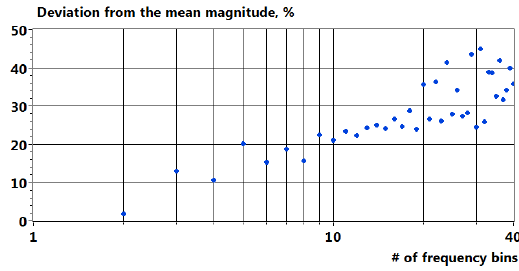
Fig.8: Relative deviation of RMS magnitudes of frequency components from their mean values of the signum chirp with normalized frequencies in the range from 10 to 50.